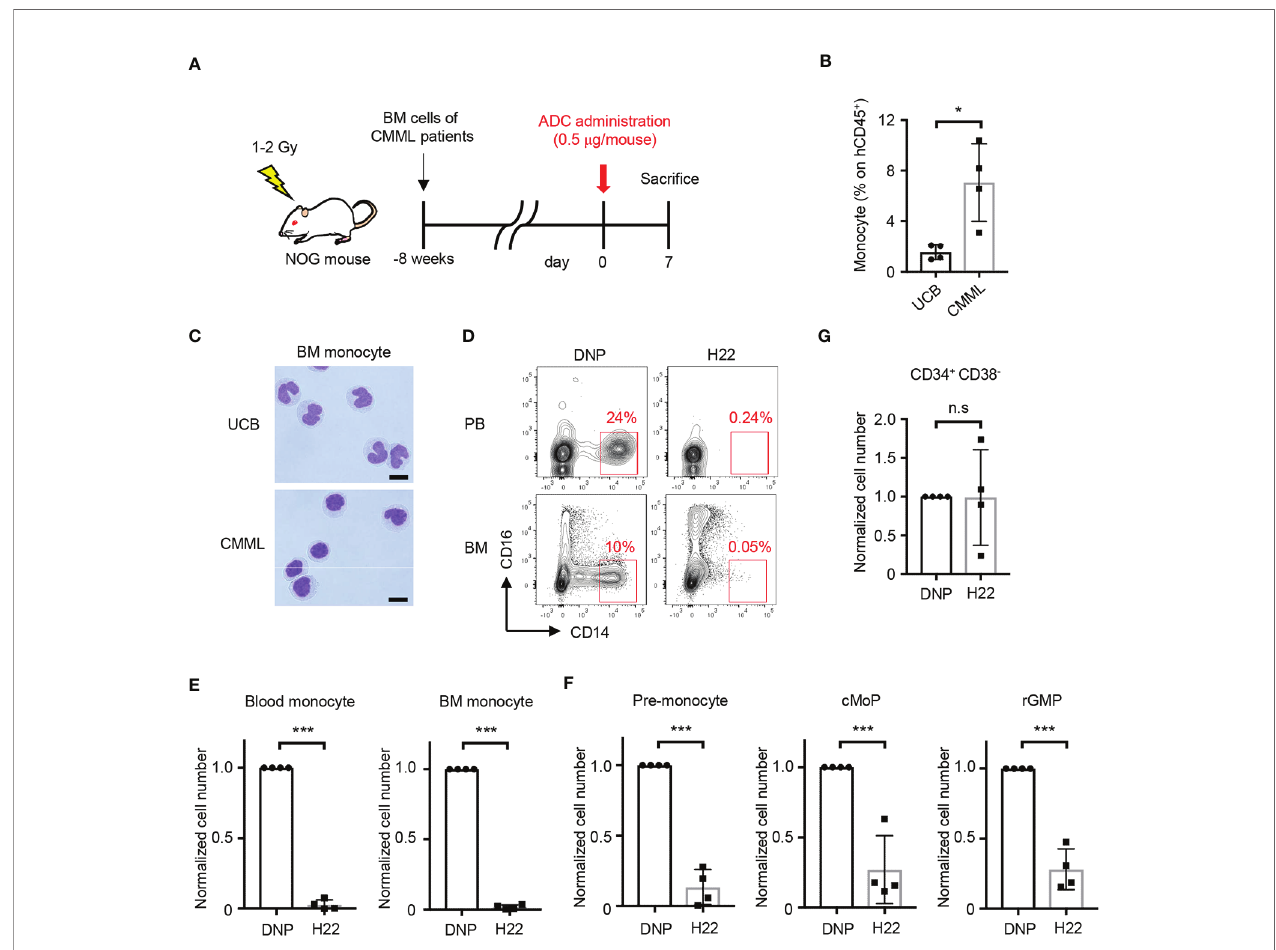
FIGURE 5 | H22-dPBD eliminates patient-derived leukemic monocytes in vivo . (A) Experimental scheme showing the treatment of PDX mice with ADCs. CMML patient-derived Lin - CD34 + BM cells were transferred to sublethally irradiated NOG mice 8 weeks before the administration of DNP-dPBD or H22-dPBD (0.5 µg/ mouse). The mice were analyzed 7 days after the ADC treatment. (B, C) Frequency of hCD45 + cells (B) and cell morphology (C) of BM CD14 hi CD16 - monocytes obtained from NOG mice humanized with normal UCB or CMML patient-derived BM cells. Cells were sorted and stained with Diff-quik (scale bars, 5 µm). (D) Representative FCM plots of hCD45 + cells in the peripheral blood (upper panels) or BM (lower panels) from DNP-dPBD- or H22-dPBD-treated PDX mice. (E – G) Impact of ADC-treatment in hematopoiesis of PDX mice. Cell numbers of monocytes, monocytic progenitors and Lin - CD34 + CD38 - cells are shown in (E) , (F) , and (G) , respectively. Each point in the bar graphs shows the value for an individual mouse (n=4 per group). Error bars represent standard deviation of the mean. Student ’ s t -test was used to assess statistical signi fi cance. * p < 0.05, *** p < 0.001; n.s, not signi fi cant. Data are representative (C, D) or pooled (B, E – G) from four independent